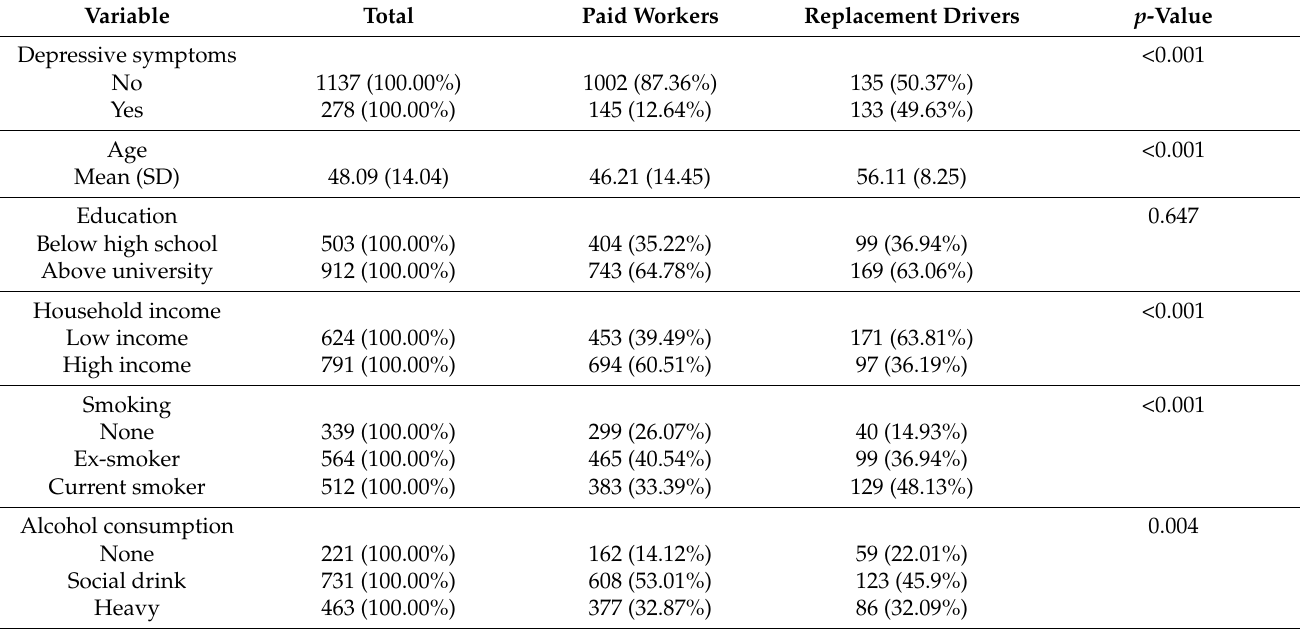
Table 1. Baseline characteristics of participants stratified by replacement